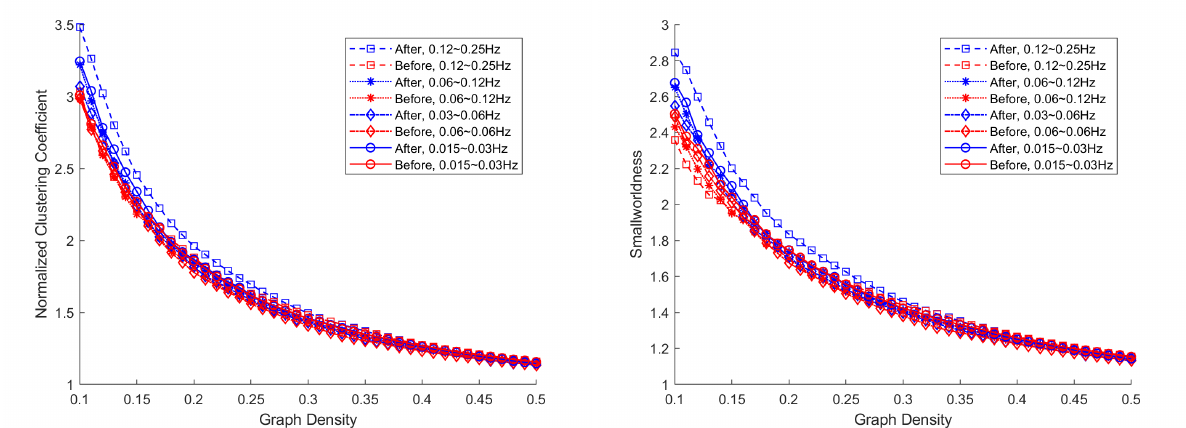
Figure 2. Mean global network measures, normalized clustering coefficient, and smallworldness across graph density in 4 frequency bands for before and after 8-week SSRI